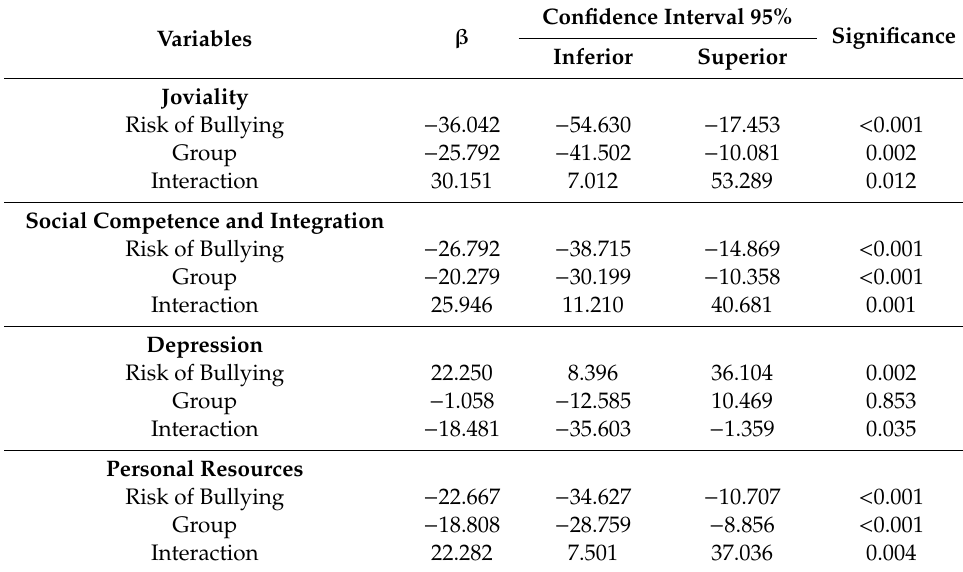
Table 4. Interaction of “Risk of bullying” with Group on Joviality, Social Competence and Integration, Depression, and Personal Resources (central tendency and variability).